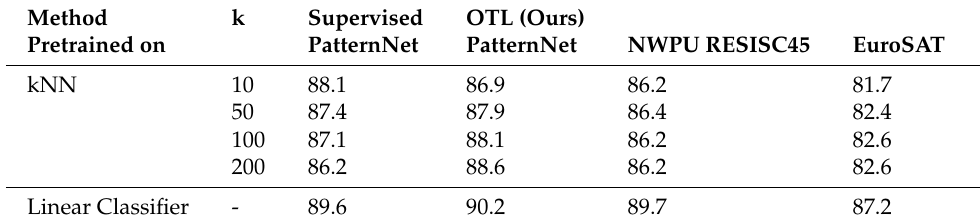
Table 9. UCMerced LandUse.